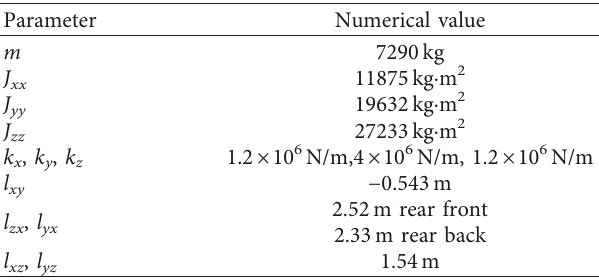
Table 1: The kinetic parameters of the ZS2560 vibrating screen.